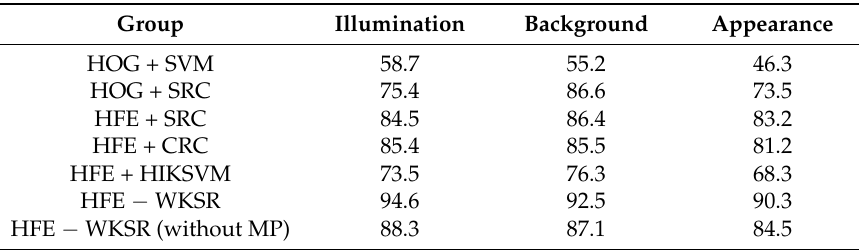
Table 4. Classification Results on Daimler database.